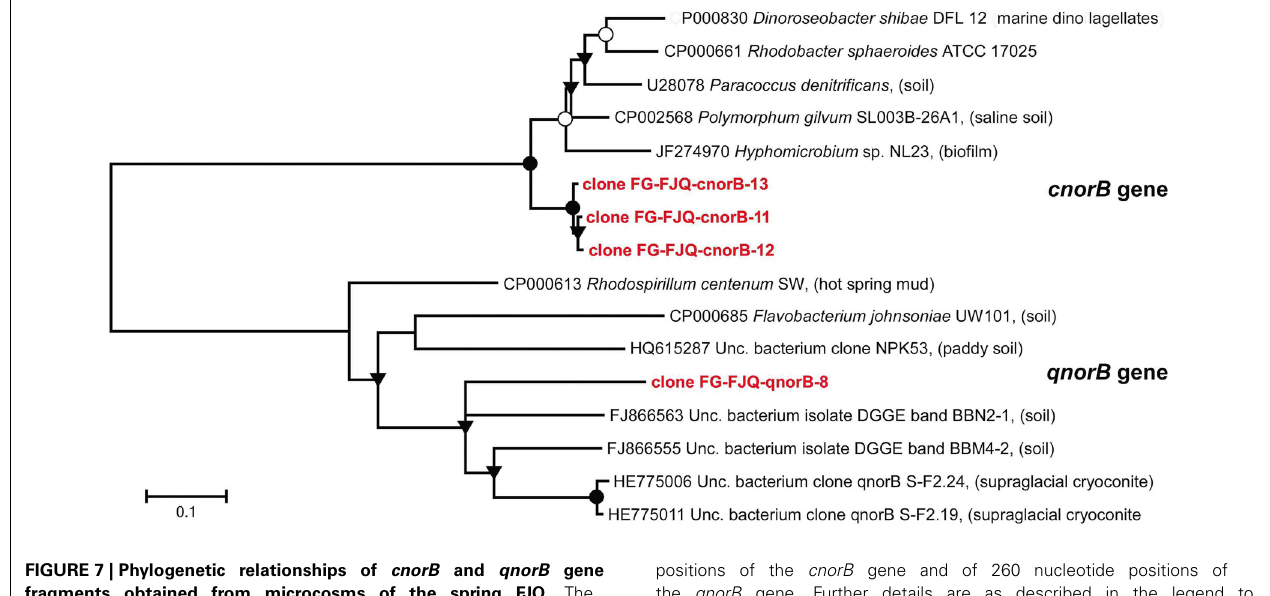
positions of the cnorB gene and of 260 nucleotide positions of the qnorB gene. Further details are as described in the legend to Figure 3 .